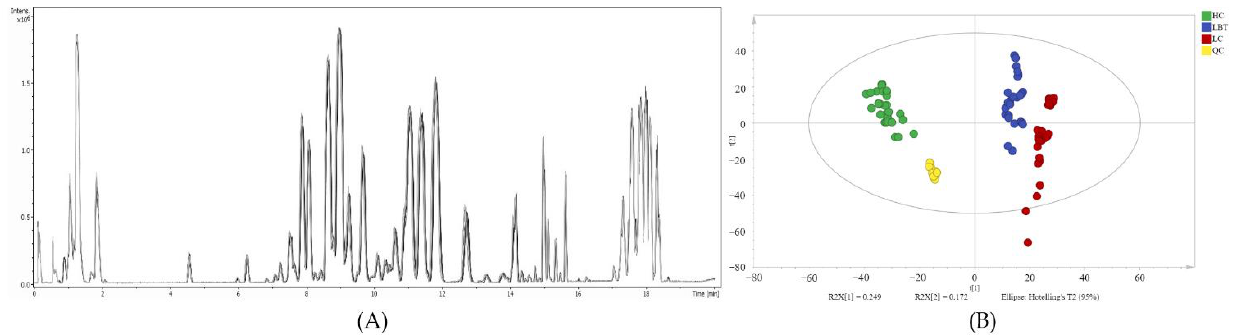
Figure 1. Total ion current chromatograms of QC serum samples (n = 15) ( A ), and principal compo- nent analysis (PCA) results of LC, LBT, and HC ( B ). (HC, healthy crowds; LBT, laryngeal benign tumor patients; LC, laryngeal cancer patients; QC, quality control.)